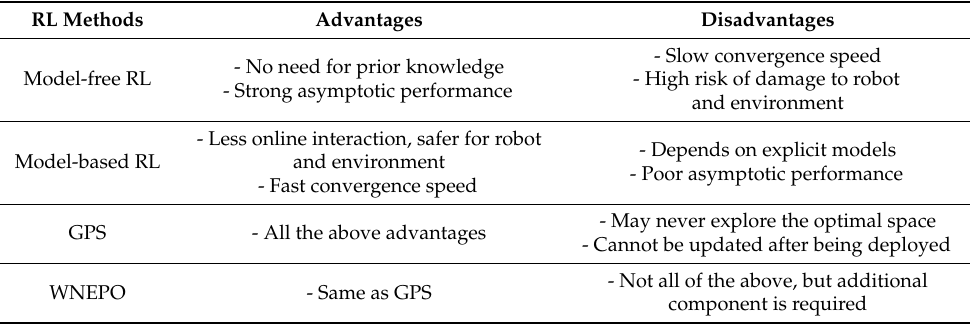
Table 1. Advantages and disadvantages of different reinforcement learning (RL)